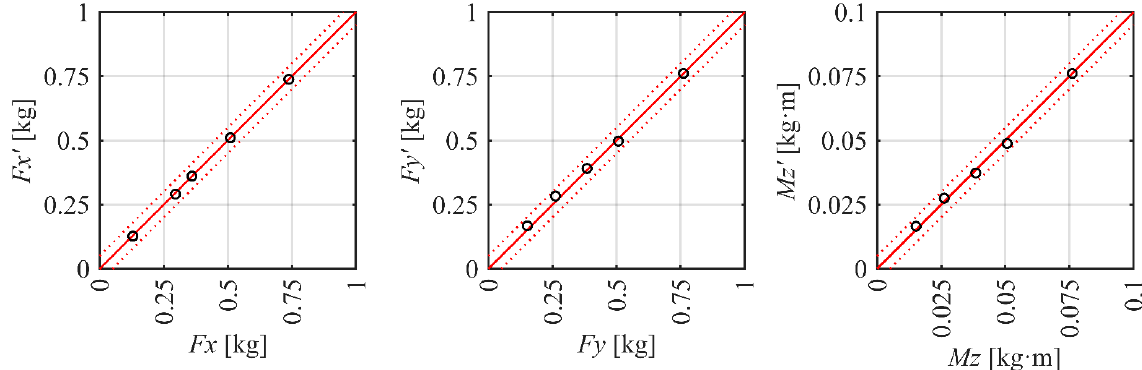
Figure 2. Balance response to a range of known weights using a two-point, linear calibration method.